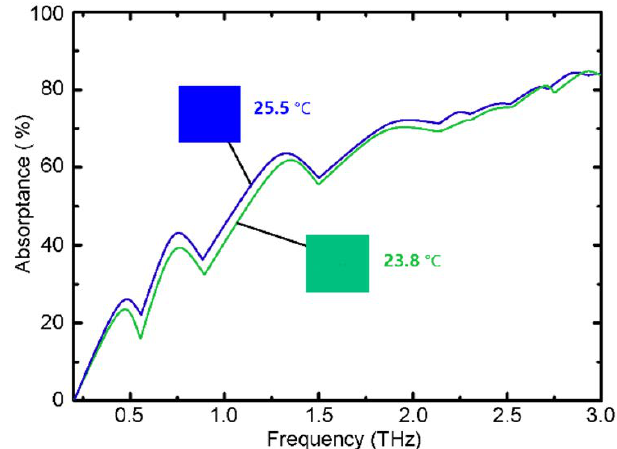
Figure 2. Effect of temperature on THz absorption spectra of CCLCF. The inset shows the photos of color change from green (23.8 °C) to blue (25.5 °C).